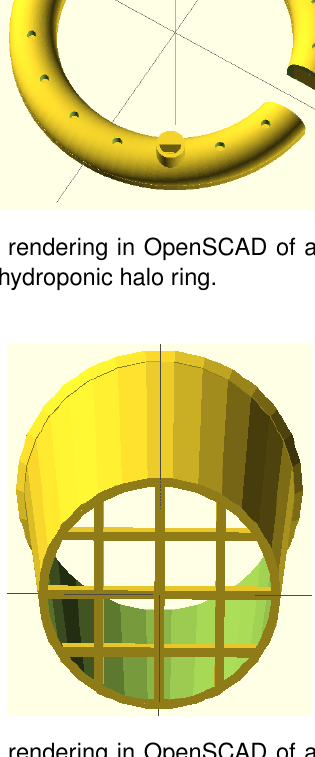
Figure 21. A rendering in OpenSCAD of a customizable 3-D printable hydroponic plant